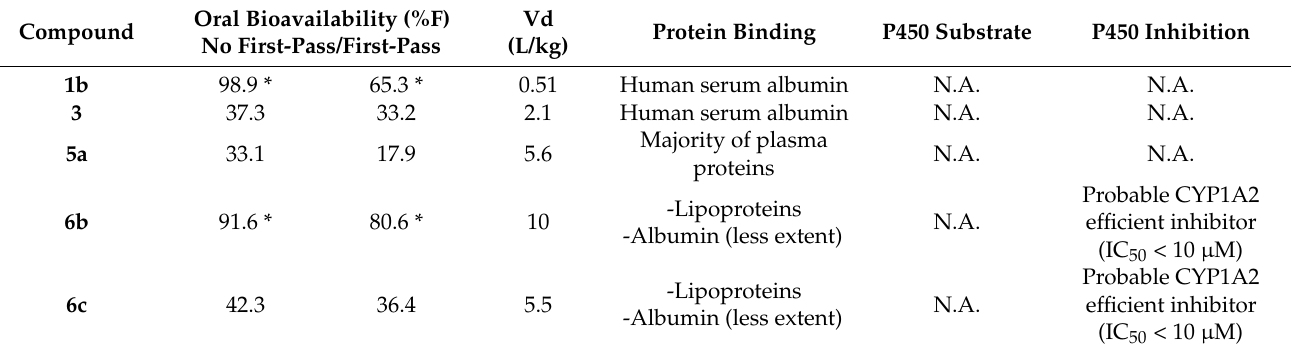
Figure 4. Inhibition of mycelium growth of six pathogenic fungal species on malt extract agar by the tested compounds (25 mg/L). ( a – e ) groups 1—6 of the tested compounds. Error bars represent the standard deviation of the mean. Table 3. Toxicokinetics (ADME) characterization of hit compounds performed with the ACD/Percepta suite. The parameters reported are: %F of oral bioavailability (determined ignoring and considering the first-pass effect), volume of distribution (Vd), and probabilities of being Cyt P450 substrates and/or